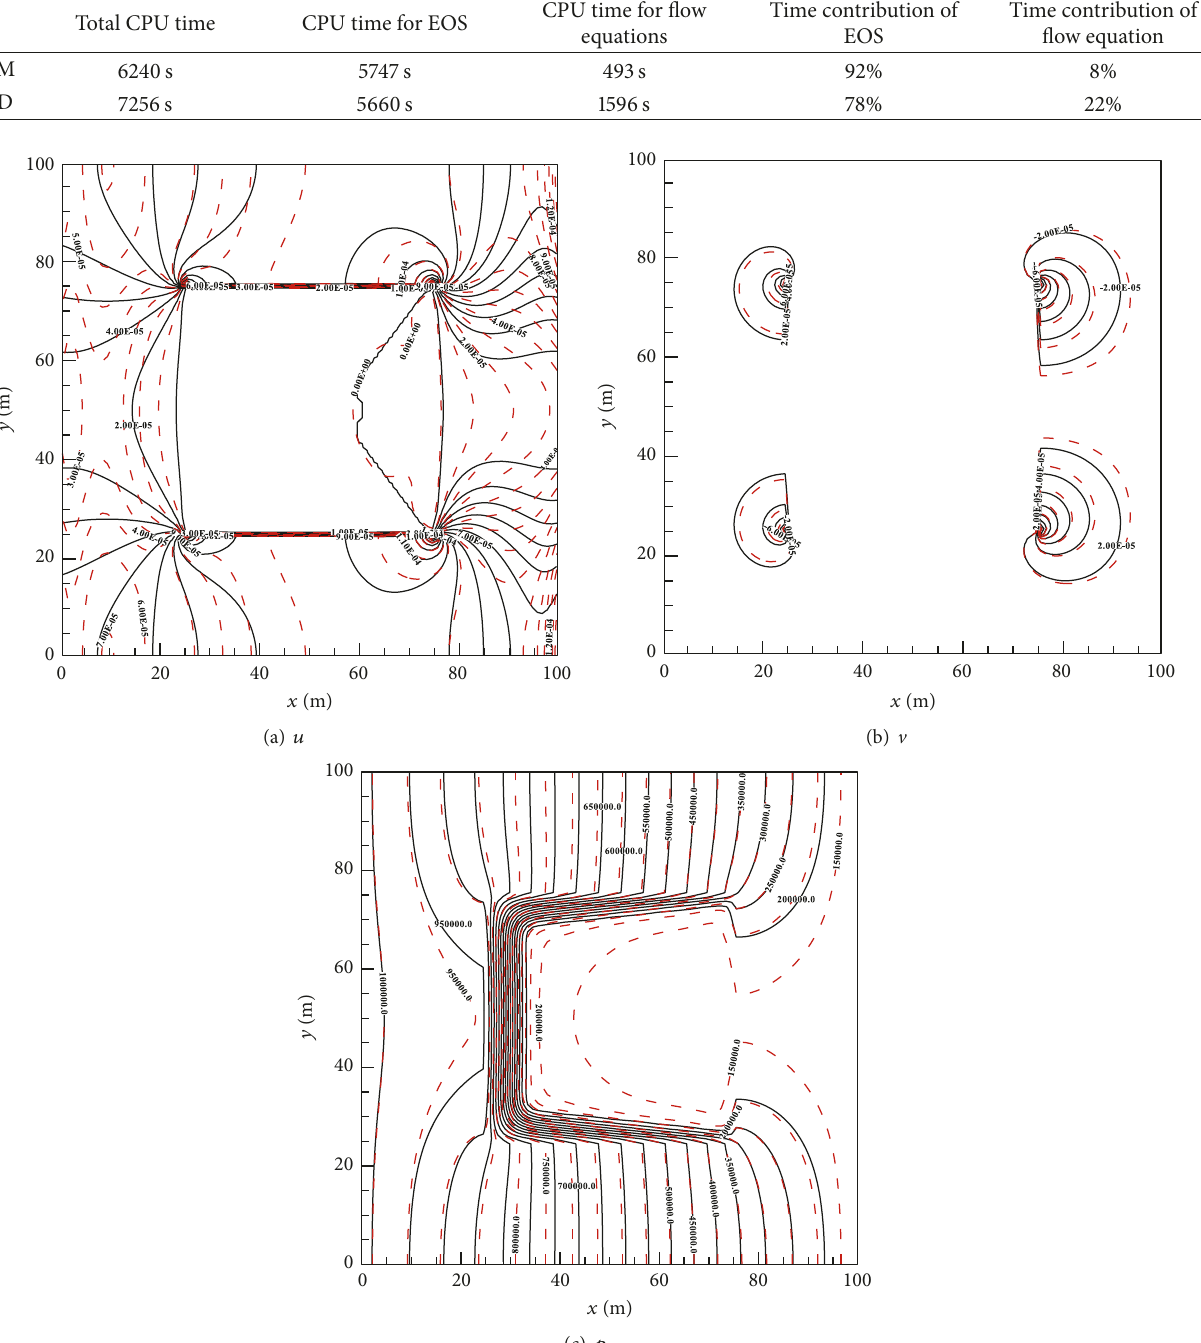
Figure 5: Flow field comparison for the maximum deviation. Black line: FDM; red dashed line: